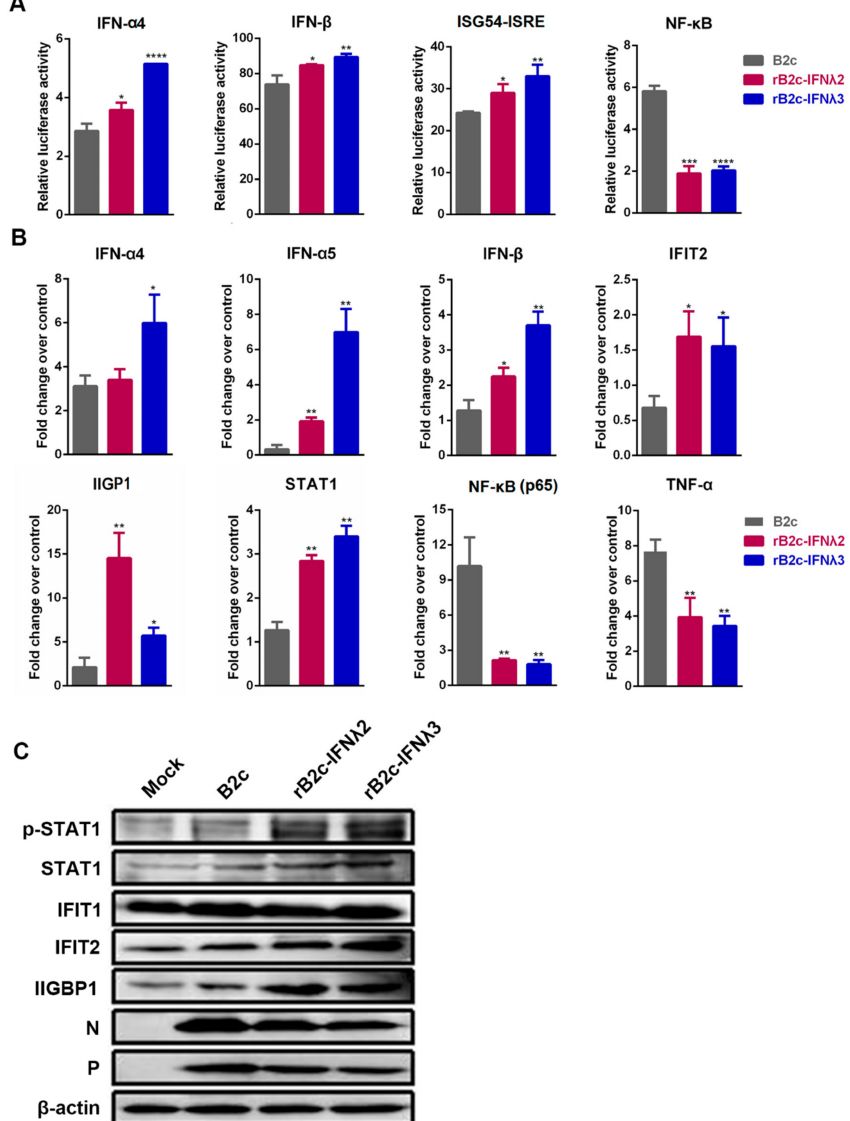
Figure 5. IFN- λ activates STAT1 / 2 and enhances the production of ISGs. ( A ) NA cells were transfected with plasmids encoding IFN- α 4, IFN- β , ISG54-ISRE or NF- κ B firefly luciferase reporter, respectively. After 24 h, cells were left uninfected or were infected for 12 h with di ff erent rRABVs. Luciferase assays were performed to analyze the promoter activity of ISRE, Ifn- α 4, Ifn- β and NF- κ B, respectively. Luciferase reporter activity was expressed as fold change that normalized to Renilla luciferase activity. ( B ) NA cells were infected with B2c, rB2c-IFN λ 2, or rB2c-IFN λ 3 at a MOI of 1. At 24 hpi, total RNA was isolated and Ifn- α 4, Ifn- α 5, Ifn- β , STAT1, IFIT2, IIGP1, NF- κ B (p65), and TNF- α mRNA levels were analyzed by qRT-PCR. ( C ) Protein levels of STAT1, IFIT1, IFIT2, IIGP1, and β -actin in di ff erent rRABV-infected NA cells were measured by western blot at 24 hpi. Error bars represent the SE ( n = 3). The following notations were used to indicate significant di ff erences between groups: *, p < 0.05; **, p < 0.01; ***, p < 0.001; ****, p <